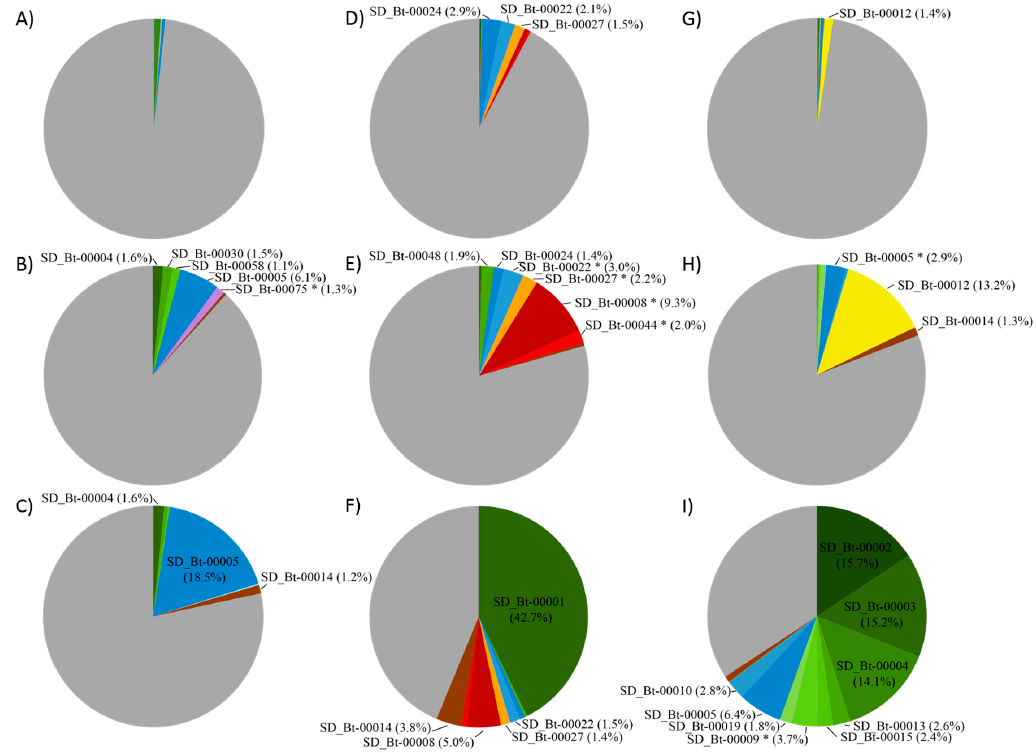
Figure 2. Composition of bacterial consortia in response to cellulose, presented as relative abundance (%). OTUs enriched in the presence of cellulose with a relative abundance of at least 1% from at least one time point are indicated. OTUs found to be statistically higher in cellulose supplemented cultures compared to their corresponding non supplemented controls are indicated (*). Cow A: ( A ) rumen sample (D0); ( B ) D7 cultures and ( C ) D14 cultures. Cow B: ( D ) rumen sample (D0); ( E ) D7 cultures and ( F ) D14 cultures. Cow C: ( G ) rumen sample (D0); ( H ) D7 cultures and ( I ) D14 cultures. OTU abundances at D7 and D14 are the average of three replicate cultures at the indicated time point. Distinct OTUs assigned to the same phylum are shown in shades of the same color: Bacteroidetes (blue), Firmicutes (green), Candidatus Saccharibacteria (red), Proteobacteria (purple), Fibrobacteres (yellow), Planctomycetes (orange), and unclassified Bacteria (brown). The remaining OTUs from each sample were grouped in the same category (grey). Relative abundances of OTUs in Control cultures are presented in Supplementary Tables S2–S4.